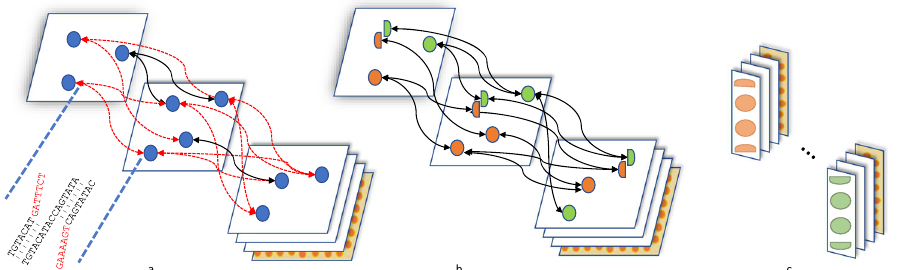
Fig. 2 | Illustration of a multi-layer computer graph in GALA. a The preliminary assemblies and raw reads are aligned against each other and encoded into a multi- layergraph. Con fl icted alignments are encoded with edgesinred. b Thecon fl icted alignments are removed iteratively by splitting the nodes involved and new edges